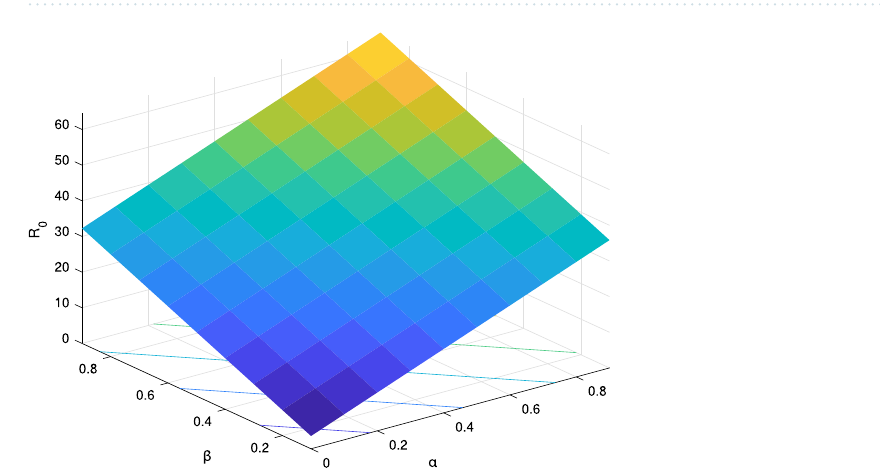
Figure 7. The densities of ( a ) I 1 ( t ) , ( b ) I 2 ( t ) , ( c ) M 2 ( t ) , ( d ) M 3 ( t ) change over time under different control strategies.